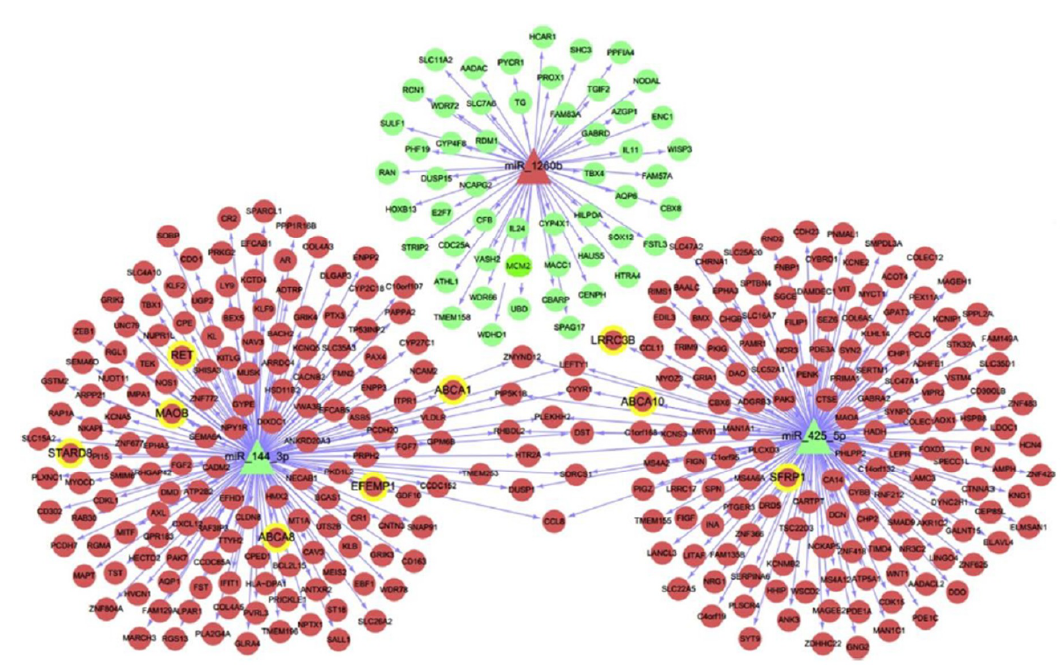
Figure 2. Schematic of the selected miRNA–mRNA networks involved in colorectal cancer (CRC). Red indicates a higher level in CRC and green represents a lower level compared with controls. The triangle refers to miRNAs, and the circle refers to target genes. Yellow refers to MARKER genes related to CRC that are recruited in the Comparative Toxicogenomics Database (CTD) database. In tumors, miR-1260b possesses 53 target genes that are significantly down-regulated, whereas miR-425-5p and miR-144-3p possess 159 and 162 target genes, respectively, that were significantly upregulated. A total of nine MARKER-related genes are found in CRC, including ATP-binding Cassette Transporter A1 (ABCA1), ATP-binding Cassette Transporter A8 (ABCA8), EGF Containing Fibulin Extracellular Matrix Protein 1 (EFEMP1), Monoamine Oxidase B (MAOB), REarranged during Transfection (RET), StAR Related Lipid Transfer Domain Containing 8 (STARD8), ATP-binding Cassette Transporter A10 (ABCA10), Leucine Rich Repeat Containing 3B (LRRC3B), and Secreted Frizzled Related Protein 1 (SFRP1). Reproduced with permission from Tan et al.